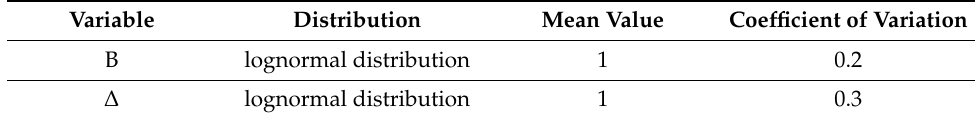
Table 4. The median and variation coefficients of random variables.